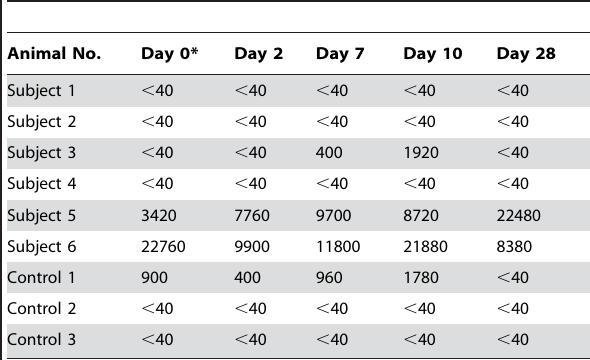
Table 2. SHIV load determined by a nucleic acid sequence- based amplification assay.